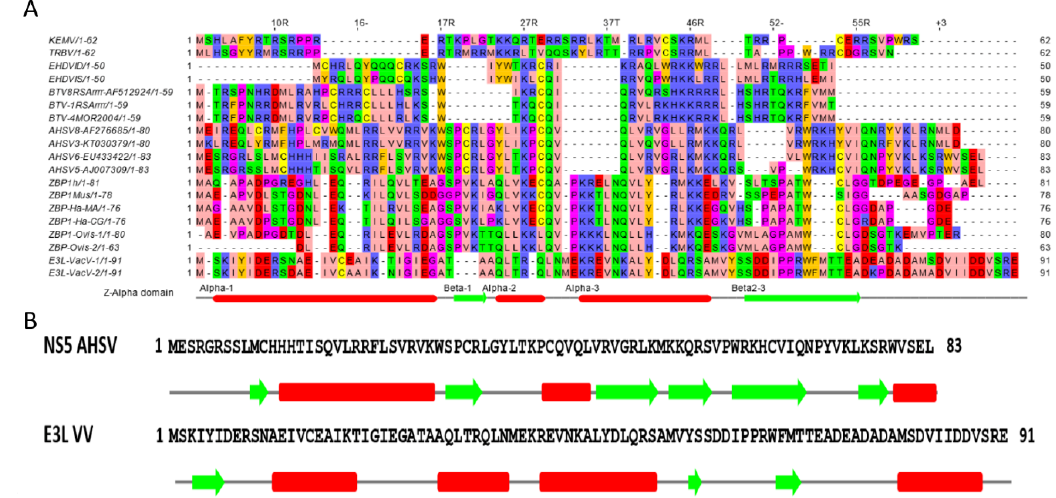
Figure 4. Prediction of secondary structures of orbivirus NS5 proteins and their relatedness to the Z-alpha domain of mammalian ZBP1 proteins and vaccinia virus E3L. Amino acid sequences were aligned with the help of the Clustal X programme. Predictions were made in JPred ( A ) and predictprotein ( B ). Amino acids are coloured according to their physicochemical properties: residues ILVAM (aliphatic hydrophobic: pink), FWY (aromatic: orange), KRH (positively charged: purple), DE (negatively charged: red), STNQ (hydrophilic: bright green), PG (conformationally special: magenta), and C (cysteine: yellow). The alignment in ( A ) shows that the various proteins have conserved residues/motifs, which is consistent with a Z-alpha domain organization. Arrows represent sequences predicted as beta sheets, and bars represent sequences predicted as alpha helices. In ( B ), amino acids 1–83 (full-length) of AHSV NS5 and 1–91 (Z-alpha domain) of VV E3L were subjected to secondary structure predictions. A comparison of the two predicted secondary structural organisations of NS5 and E3L indicates that the two proteins contain certain positionally conserved beta sheets and alpha